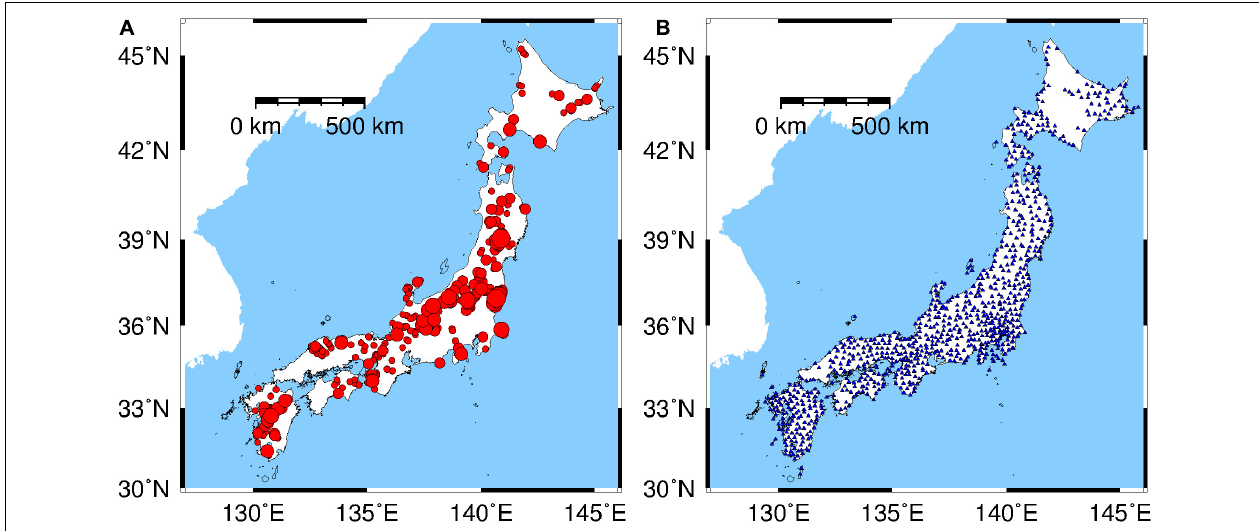
FIGURE 1 | (A) The epicenter locations of the 1,836 inland earthquakes used in this paper. Solid red circles of different sizes indicate magnitudes within the range of 3 ≤ M JMA ≤ 7.4. (B) The distribution of the stations (solid blue triangles) that recorded the strong-motion data used in this paper.